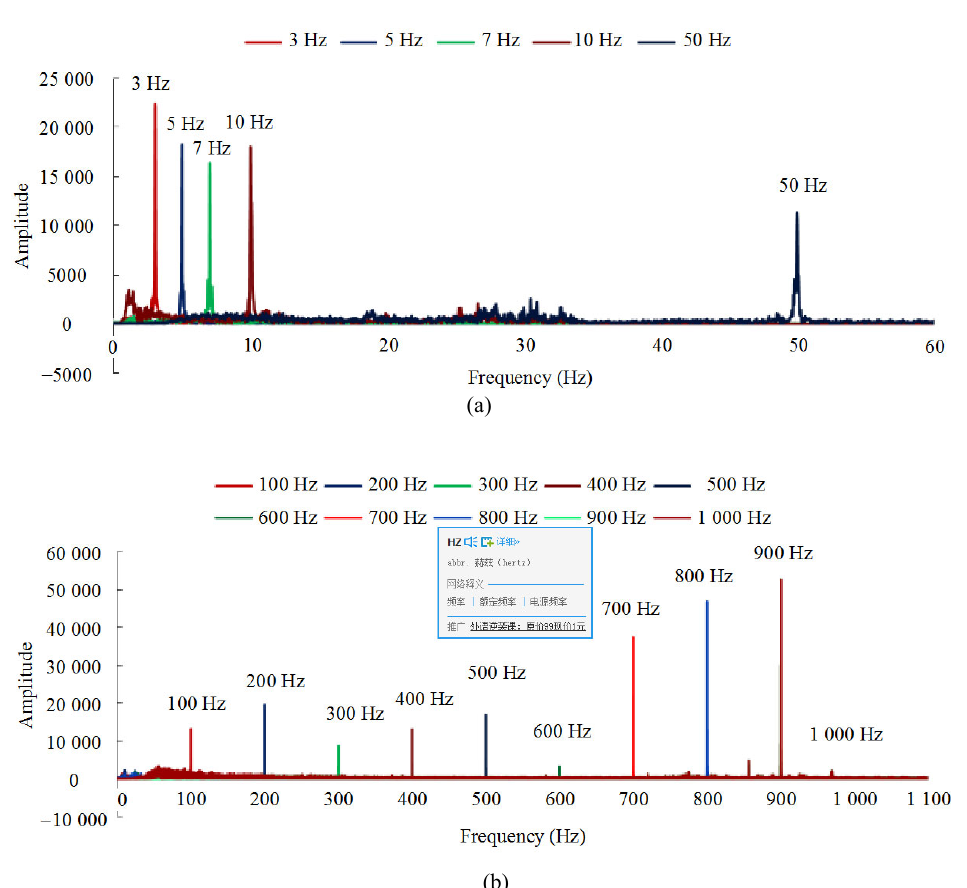
Fig. 7 Spectrum of demodulated signal at different frequencies when the sinusoidal driving voltage is 0.2 V: (a) the spectrum of the demodulated signal at the low frequencies and (b) the spectrum of the demodulated signal at the high